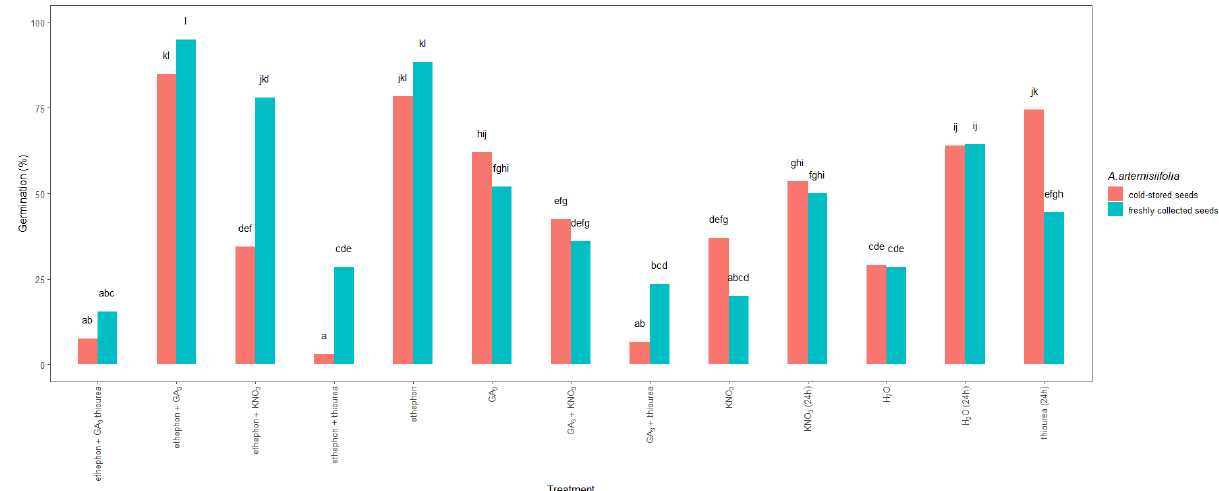
Figure 4. Total germination 14 days after sowing of freshly collected or cold-stored Ambrosia artemisiifolia seeds that were imbedded or treated with growth-promoting hormones or fertilizers. The estimated marginal means of eight replicates (standard error = 3.35) are shown. According to Tukey’s test, means following the same letter are not significantly different ( p < 0.05). No germination was observed in seeds that were treated with thiourea + KNO 3 or GA 3 + thiourea + KNO 3 ; data not shown.